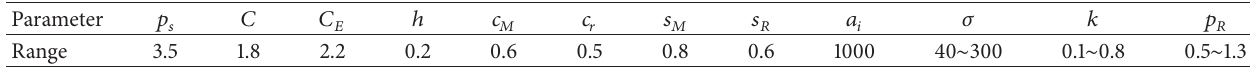
Table 1: Basic parameter